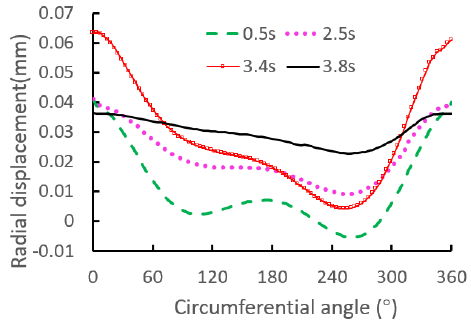
Figure 16. Periodic trend of the axial displacement at point D.